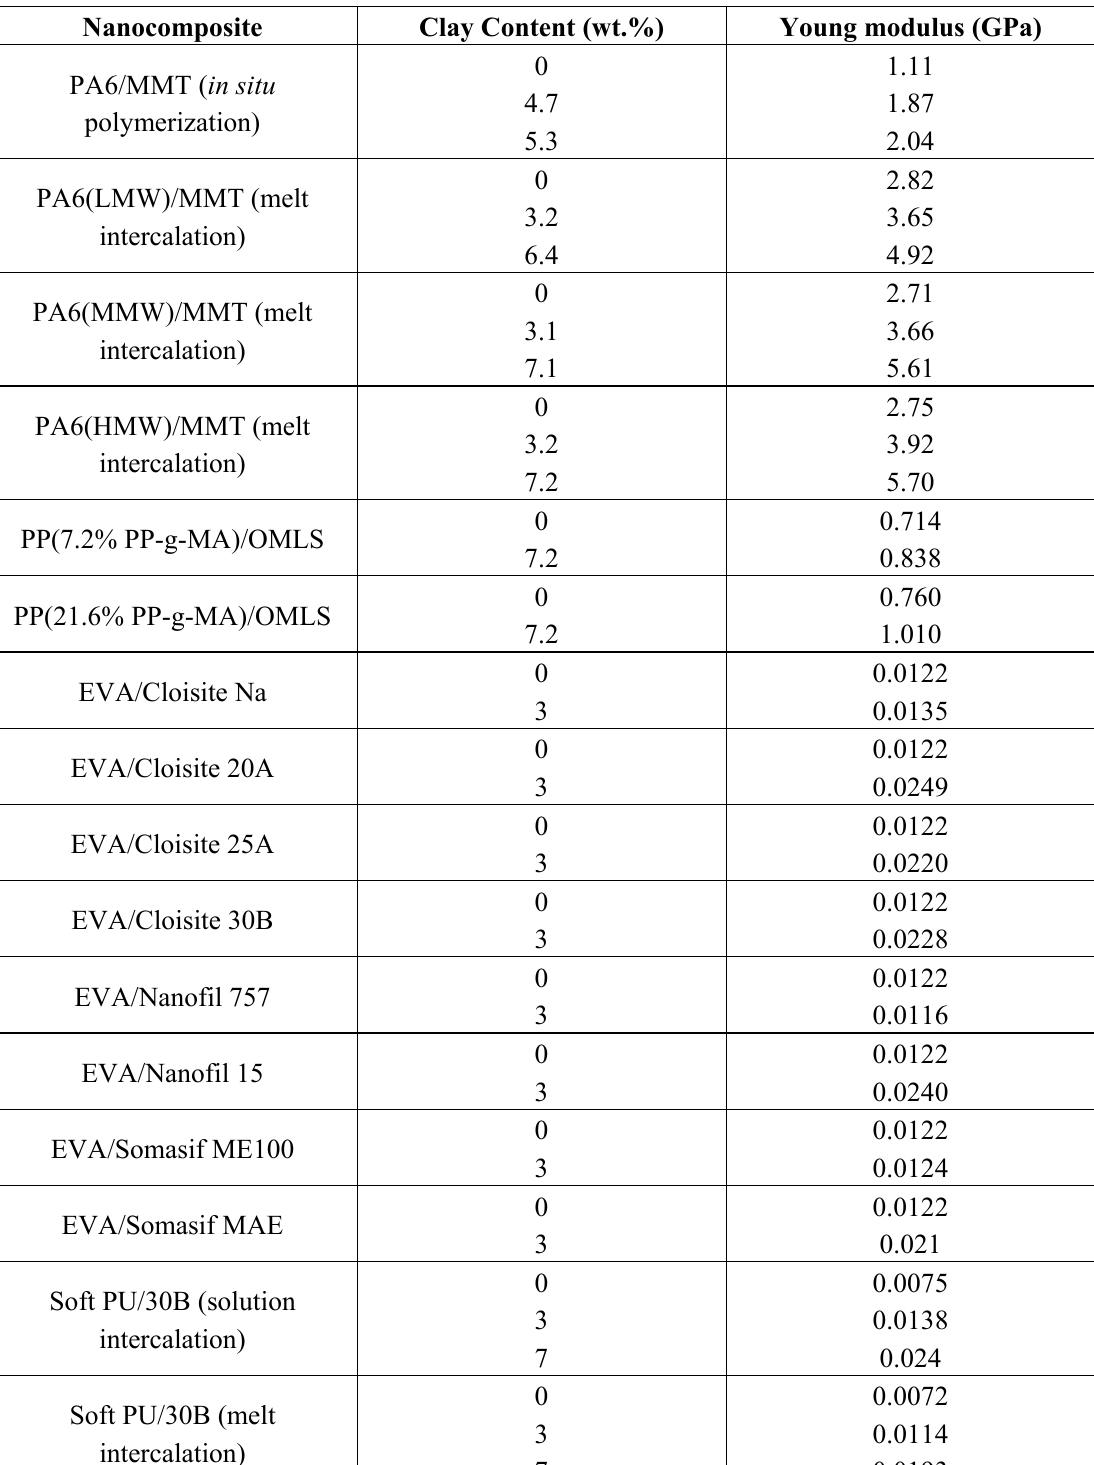
Table 2. Young modulus of polymer nanocomposites. Reproduced from reference [4] with permission from